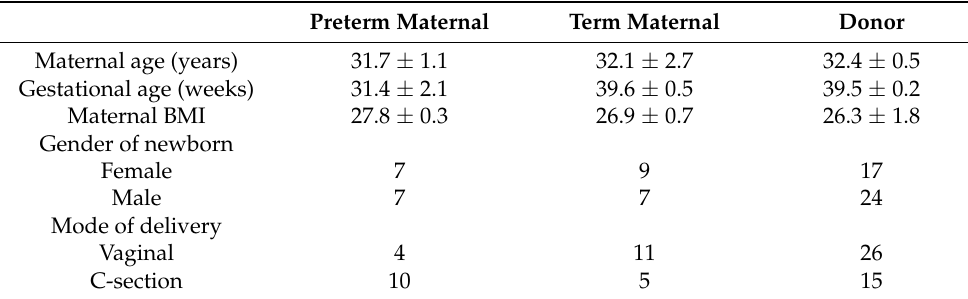
Table 1. Clinical data of enrolled patients.